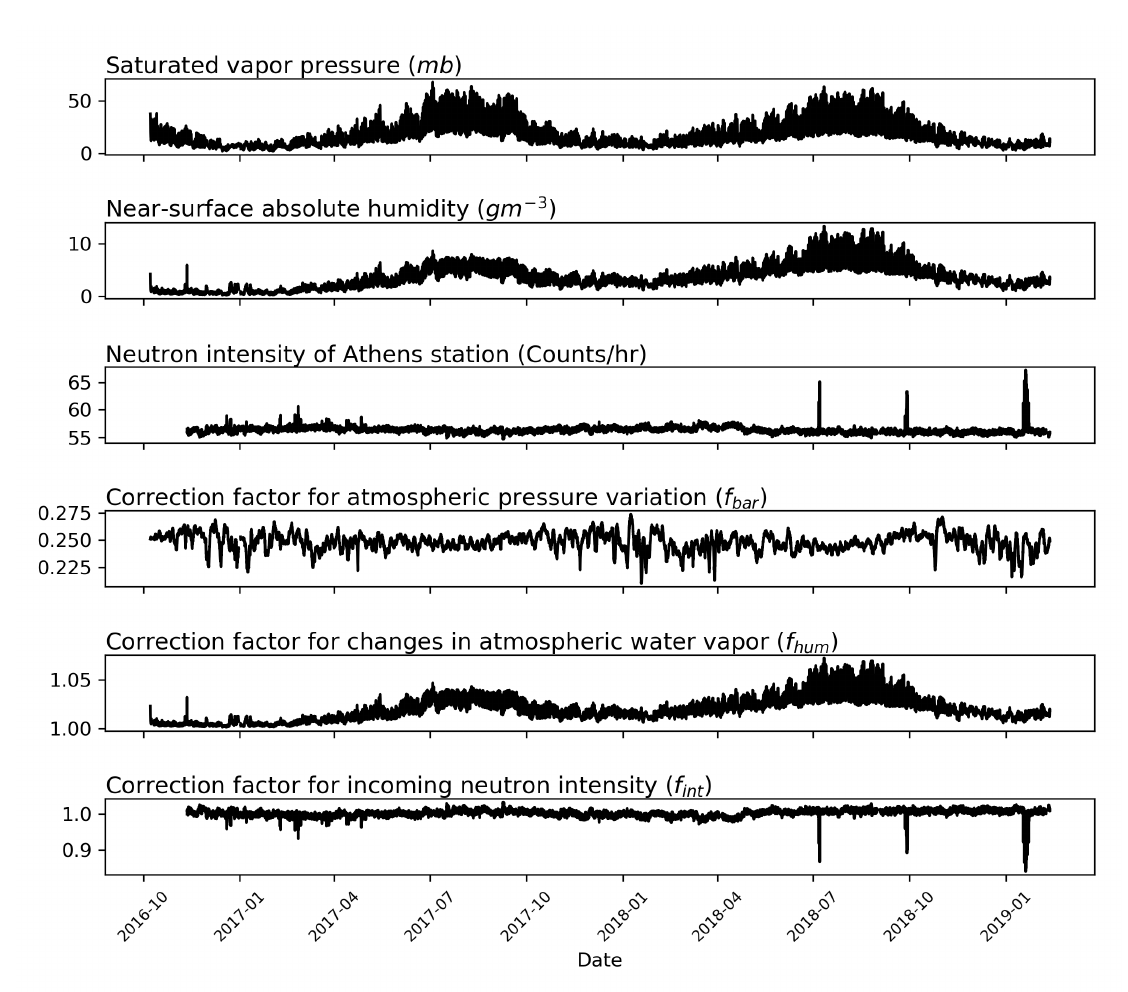
Figure 4. Variables Used for Environmental Correction and Environmental Correction